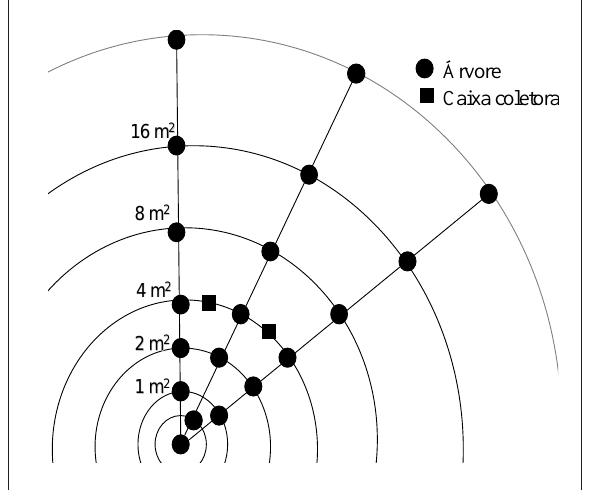
Figura 1. Esquema do círculo de